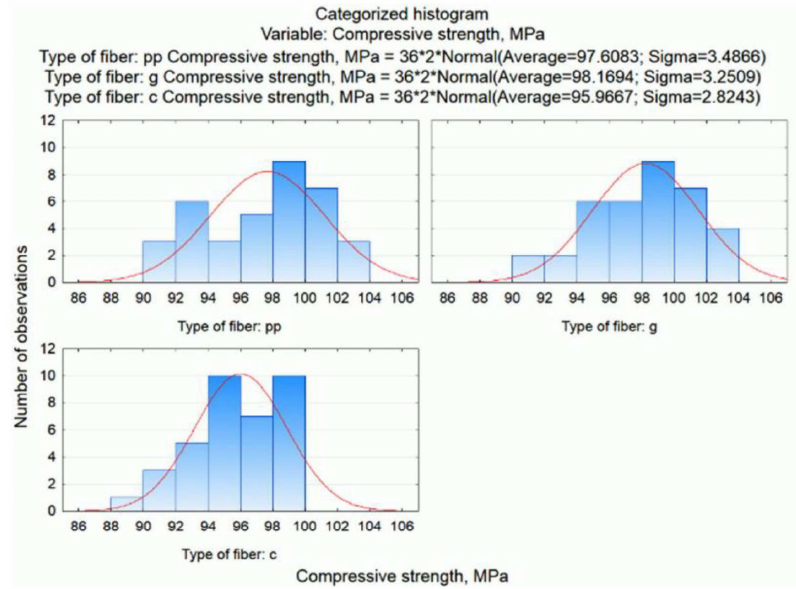
Figure 11. Categorized histograms of compressive strength related to the type of fibre.